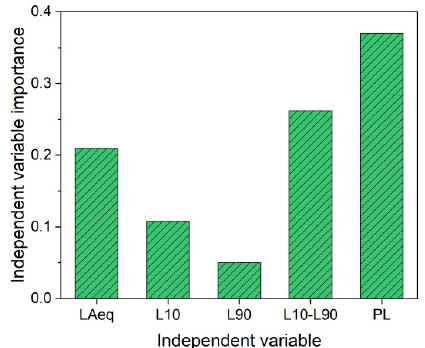
Figure 5. Prediction error for ( a ) ΔEMG, ( b ) ΔEDA, ( c ) ΔPPG, ( d ) ΔRESP and ( e ) PRR in ANNs. Figure 6 showcases the importance of input variables for determining outputs. Re- sults showed that PL impacted accuracy the most and accounted for more than 35% of the independent variable importance. This suggested that perception was a main driver for physiological parameters.